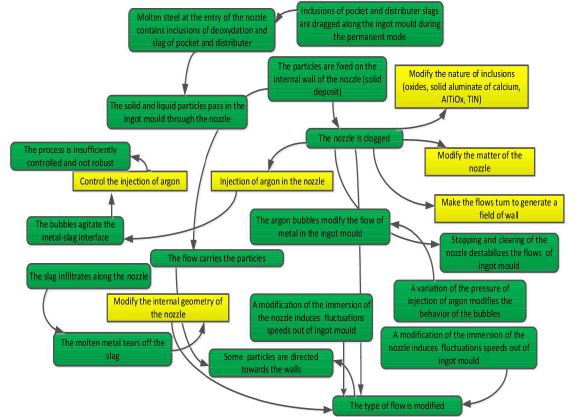
Figure 3. Problem Graph Application for formulating problems